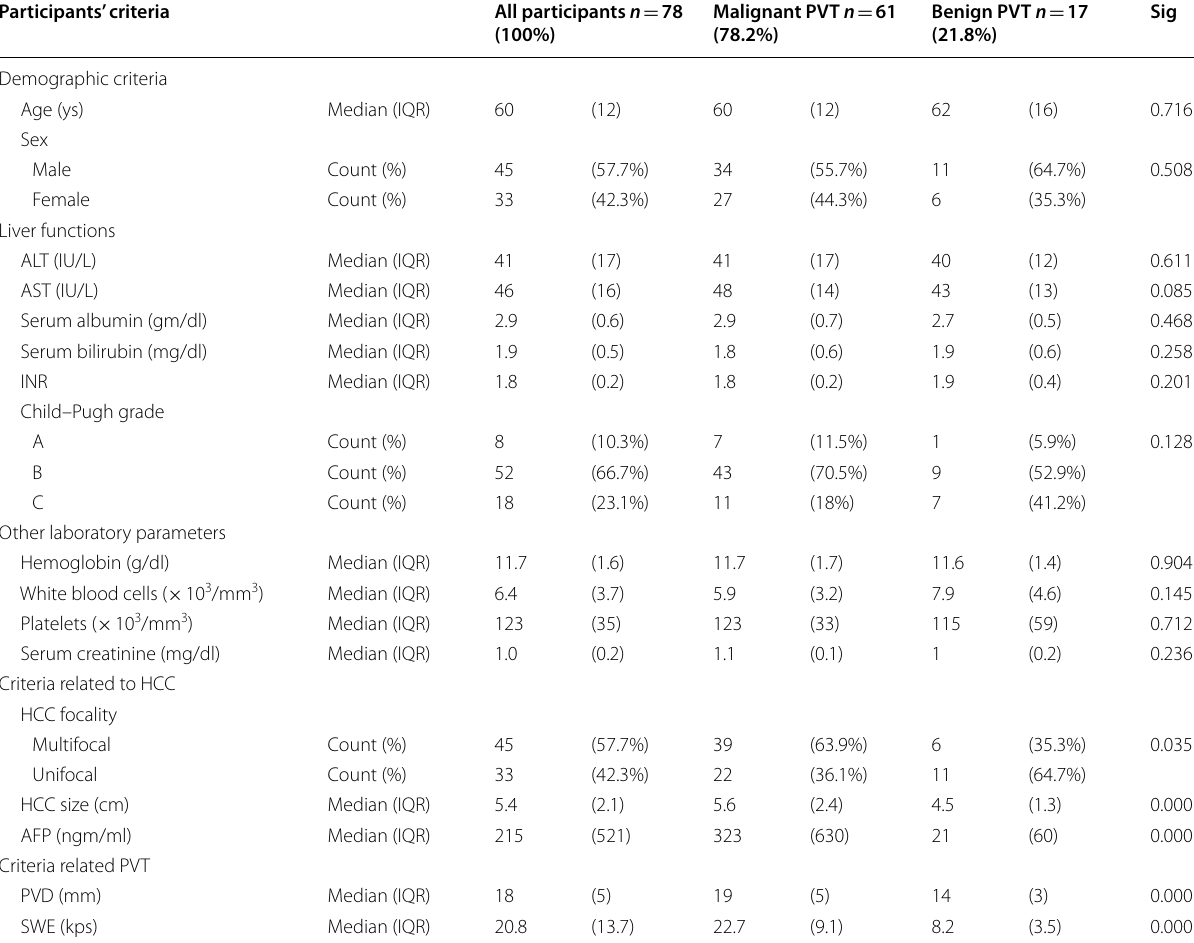
ALT Alanin aminotransferase, AST Aspartate aminotransferase, INR International normalized ratio, PVT Portal vein thrombosis, PVD Portal vein diameter, KPa Kilopascal, SWE Shear wave elastography